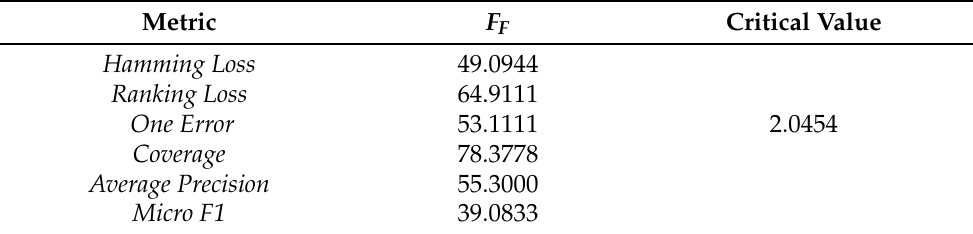
Table 3. Summary of the Friedman statistics F F ( k = 9, N = 12) and the critical value at significance level α = 0.05 in terms of each evaluation measure ( k :# comparing algorithms; N :# datasets).